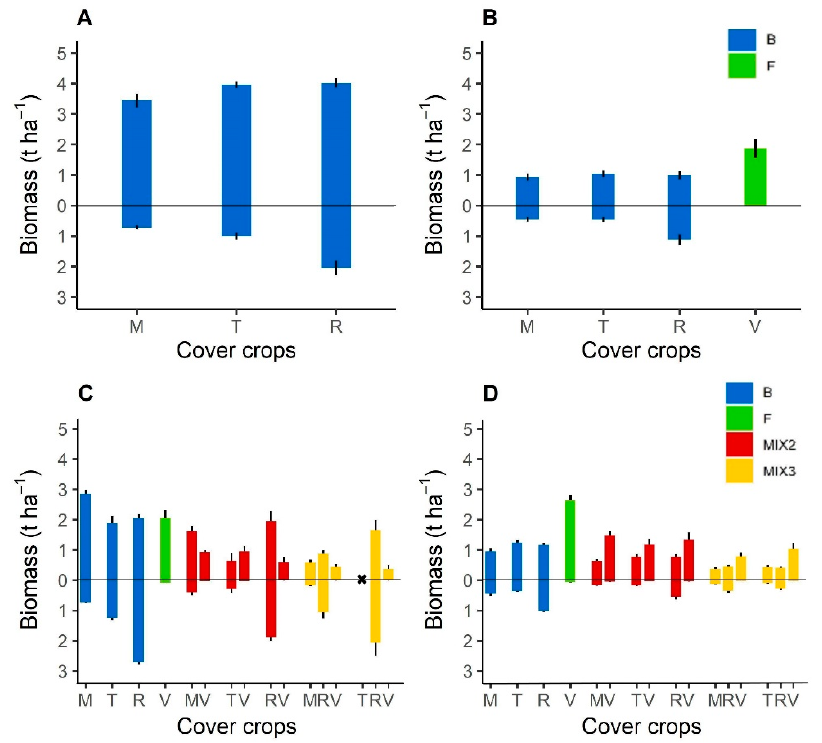
Figure 1. Shoot (above zero) and root (below zero) dry matter biomass (t ha − 1 ) for each Brassicaceae or Fabaceae species cover crops in sole crops or mixtures measured at the cover crop destruction in 2016 ( A ), 2017 ( B ), 2019 ( C ) and 2020 ( D ). In 2019, the turnip rape did not grow in a mixture of fodder radish and purple vetch. Abbreviation letter refers to cover crop species with M for brown mustard, T for turnip rape, R for fodder radish, and V for purple vetch. Error bars represent standard errors.